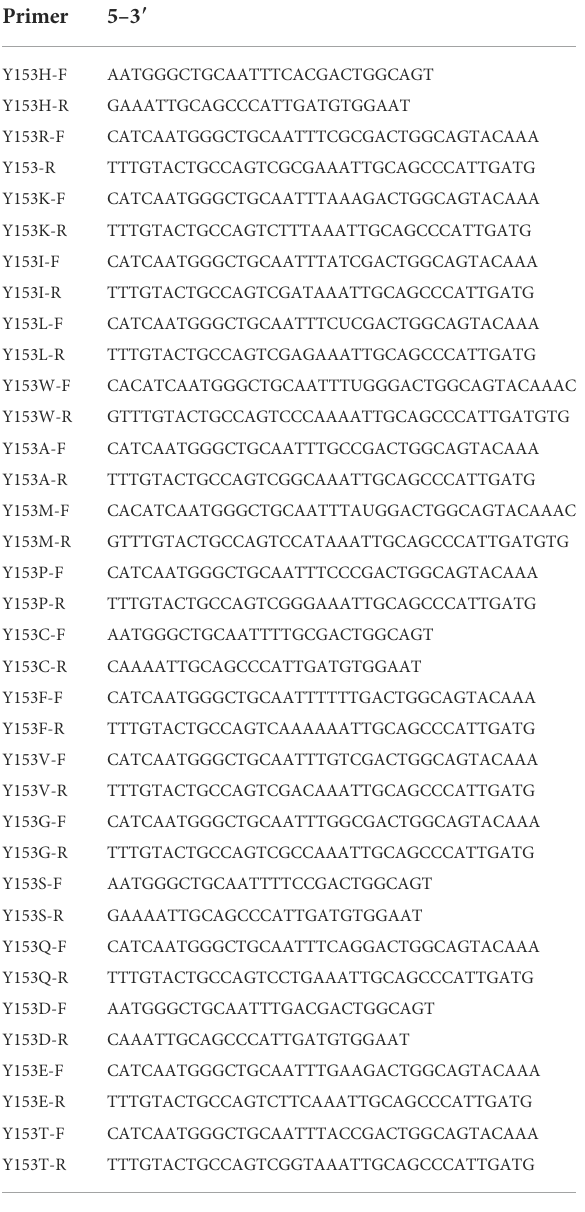
TABLE 2 PCR ampli fi cation conditions. TABLE 3 Primer design for Y153 saturation